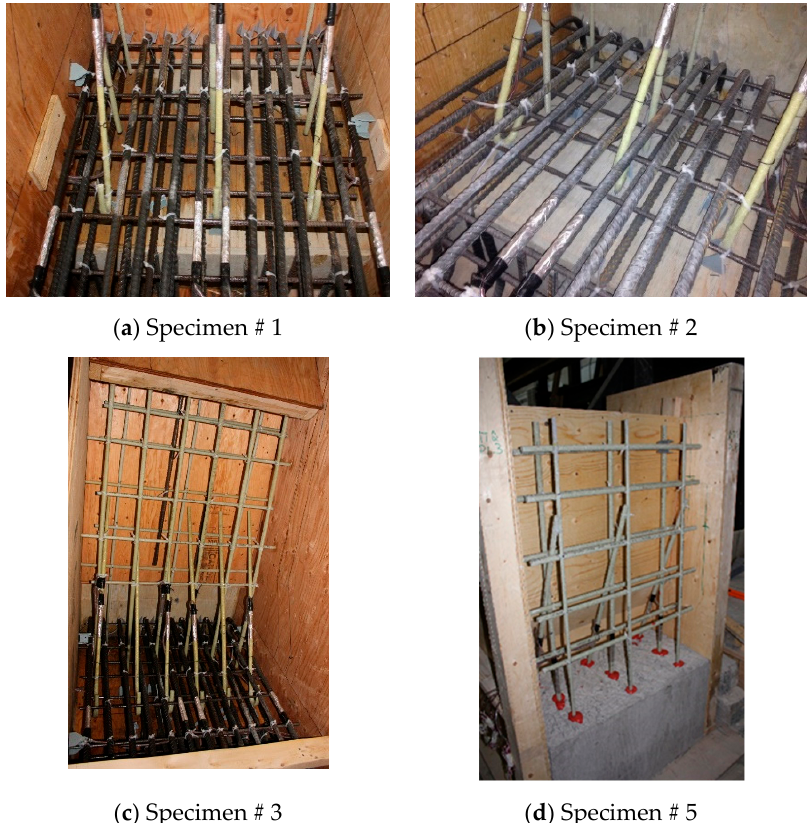
Figure 7. Specimen # 5: Interior location of the barrier connected to a non-deformable slab using post-installed bars. Materials 2019 , 12 , x FOR PEER REVIEW